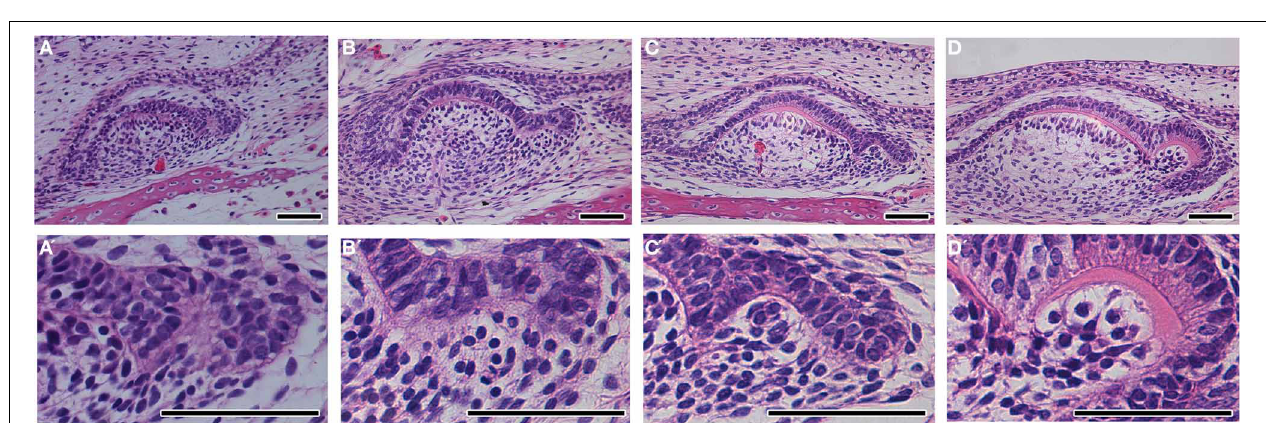
cells. (C,C’) Dentine starts to be deposited in the central crown. (D,D’) Dentine starts to be deposited in the accessory crown. (D’) the dentine of the central crown has yet to merge with that of the accessory crown. Scale bar = 50 µ